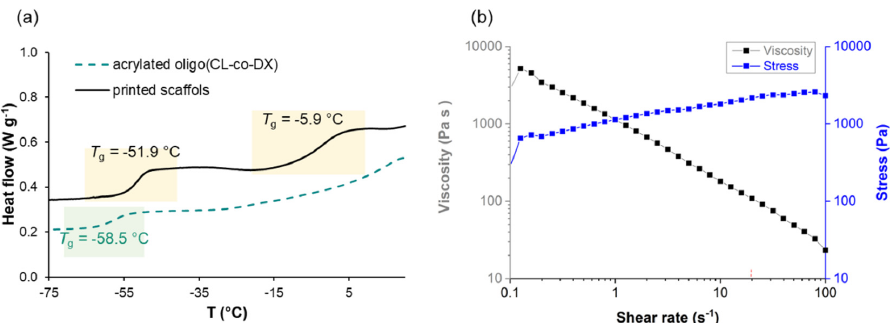
Figure 3. ( a ) DSC thermogram for the heating run, after cooling at − 80 °C, of the acrylated oligo(CL- co-DX) and printed scaffolds. Endo peak up. ( b ) Representative flow curve of the acrylated oligo(CL-co-DX).